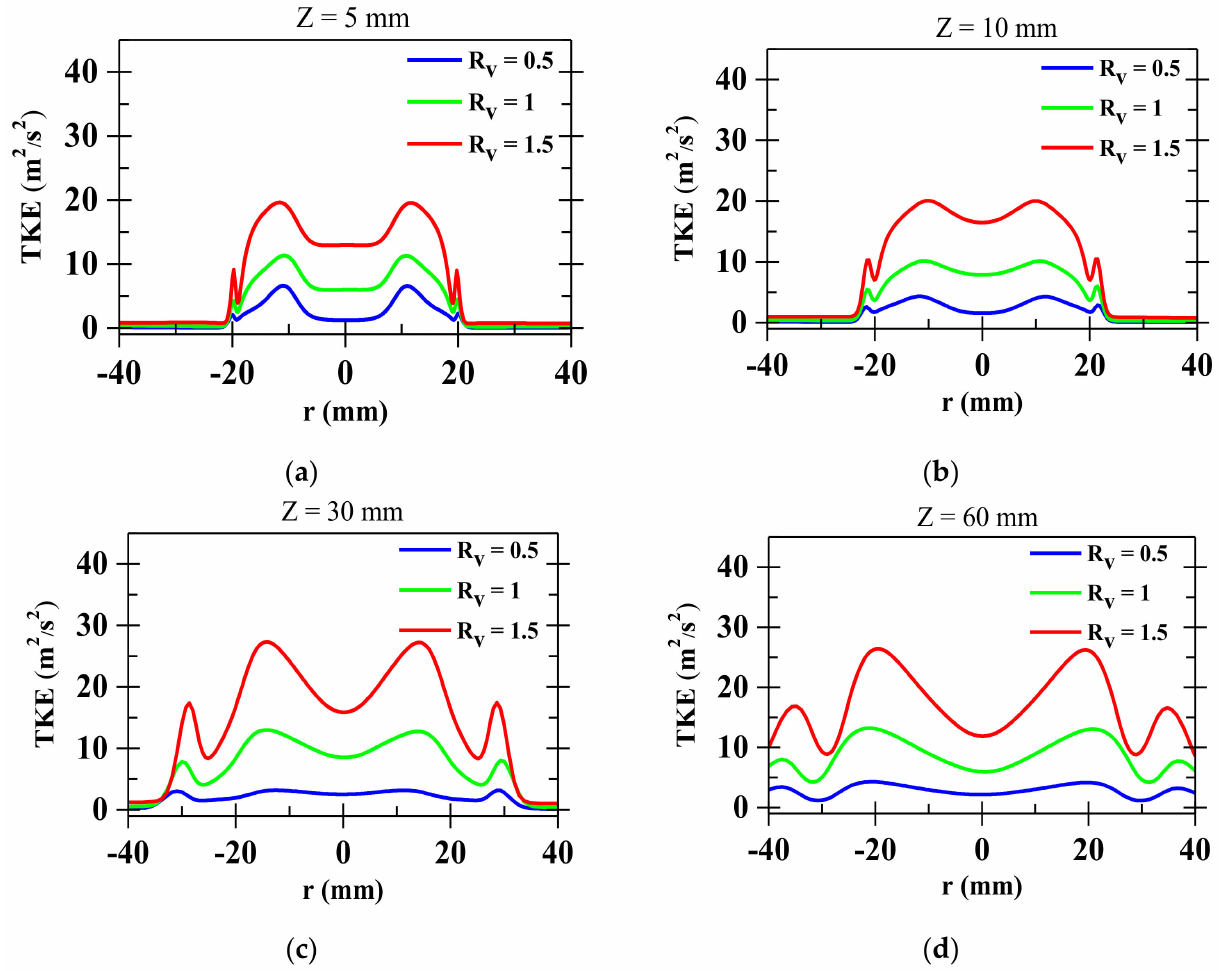
Figure 8. Computed turbulent kinetic energy (m 2 /s 2 ) for three velocity ratios obtained at different height locations; ( a ) Z = 5 mm; ( b ) Z = 10 mm; ( c ) Z = 30 mm; ( d ) Z = 60